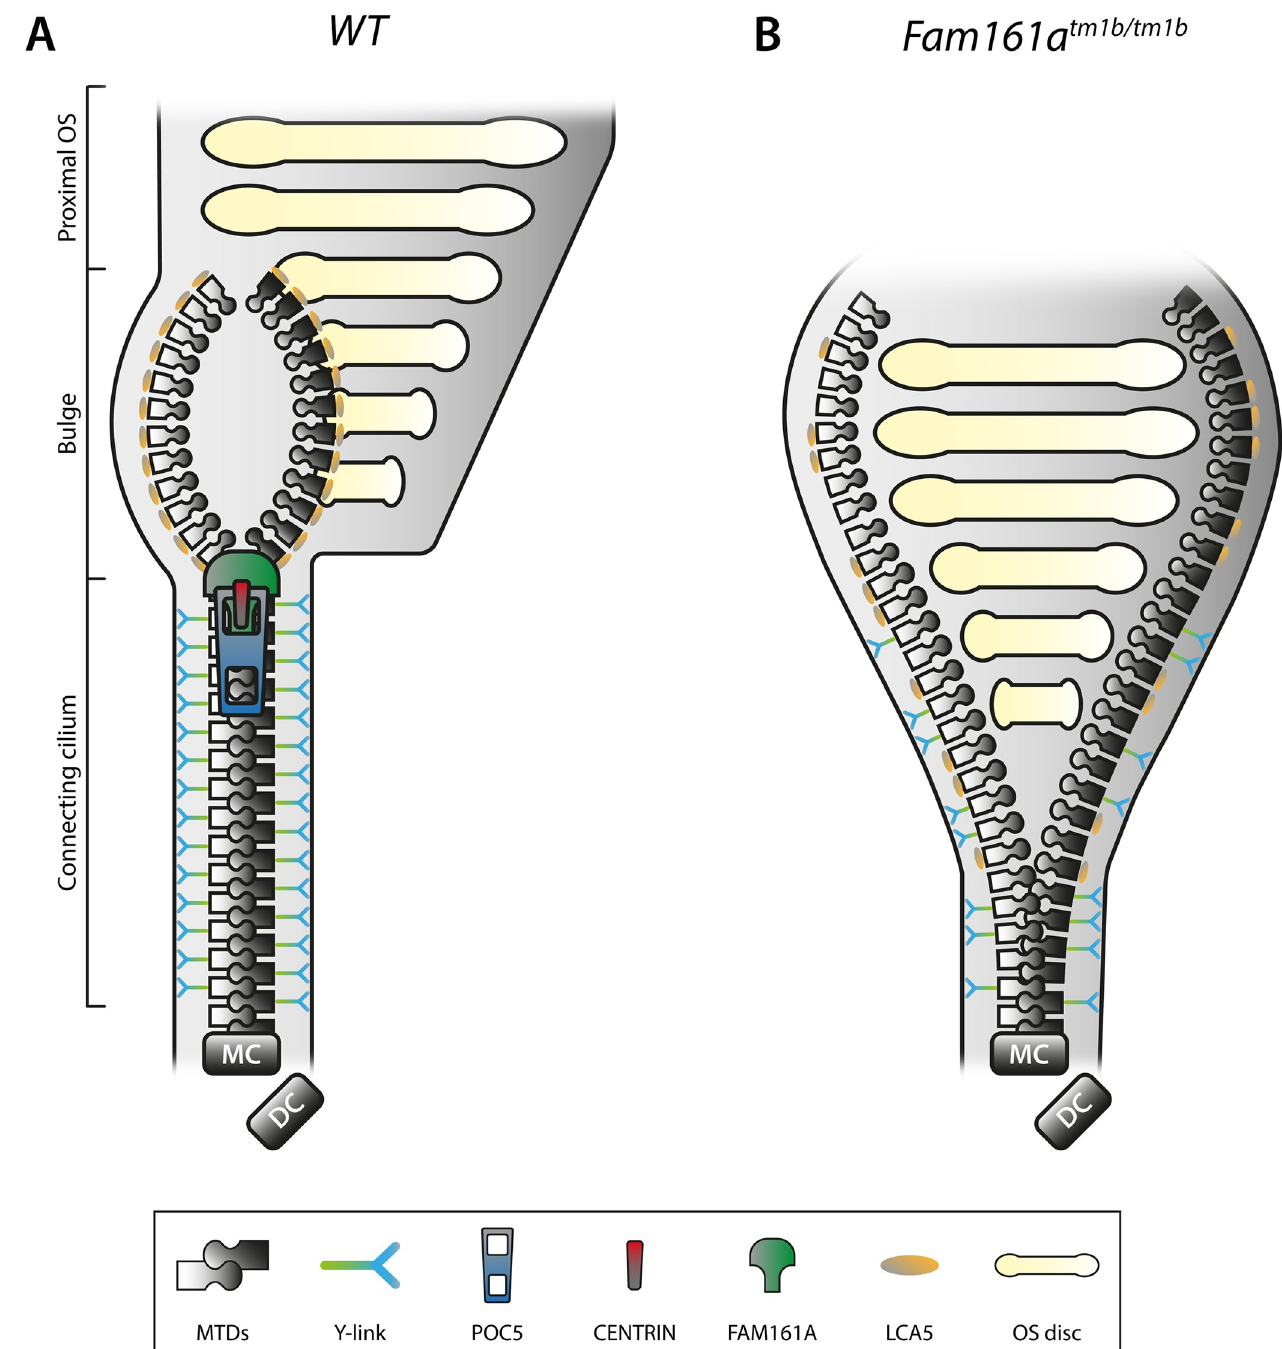
Fig 1. The CC inner scaffold acts as structural zipper providing coherence between the MTDs. (A) Schematic representation of a part of a WT rod photoreceptor consisting of the CC, the bulge region, and the proximal OS, including its membranous stacked discs. The MTDs are built up from the MC, accompanied by the DC. Cohesion of the MTDs in the CC is maintained by the inner scaffold proteins POC5, CENTRIN, and FAM161A, located at the inner wall of the MTDs, comparable with a closed zipper. Please note that these proteins are found all along the CC, in addition to the MC and DC (not shown in this diagram). MTDs in the CC are connected to the membrane by Y-links, associated with CEP290 and SPATA7 localization. LCA5 localizes to the bulge region, where MTDs are more dispersed due to the absence of the inner scaffold and Y-links. (B) Deficiency of FAM161A causes loss of the entire zip head (the CC inner scaffold) as also POC5 and Centrin are absent, leading to spreading of the MTDs. This spreading, visualized by an open zipper, eventually causes a collapse of the OS structure. Protein localization at the Y-links level is secondarily affected when FAM161A is depleted, as seen by more dispersed CEP290 localization. Furthermore, FAM161A deficiency results in disorganization of the bulge region, obvious from LCA5 localizing more proximal to the MC. Altogether, the CC inner scaffold forms a structural foundation securing proper disc formation and OS integrity. D AU : AnabbreviationlisthasbeencompiledforthoseusedthroughoutFig 1 : Pleaseverifythatallentriesarecorrect : C, daughter centriole; CC, connecting cilium; MC, mother centriole; MTD, microtubule doublet; OS, outer segment; WT, wild-type.